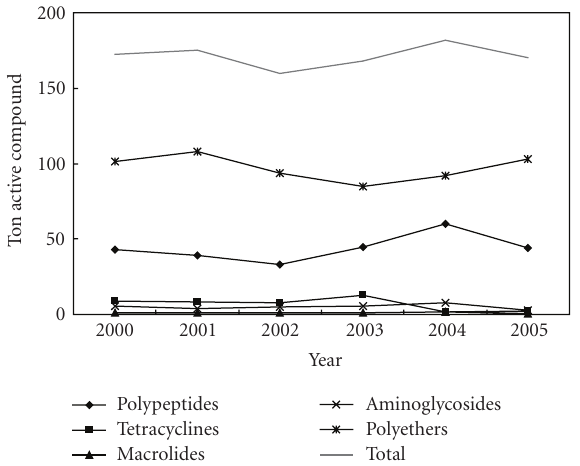
Figure 2: Trends in assay acceptable amounts of antimicrobial feed additives in Japan.